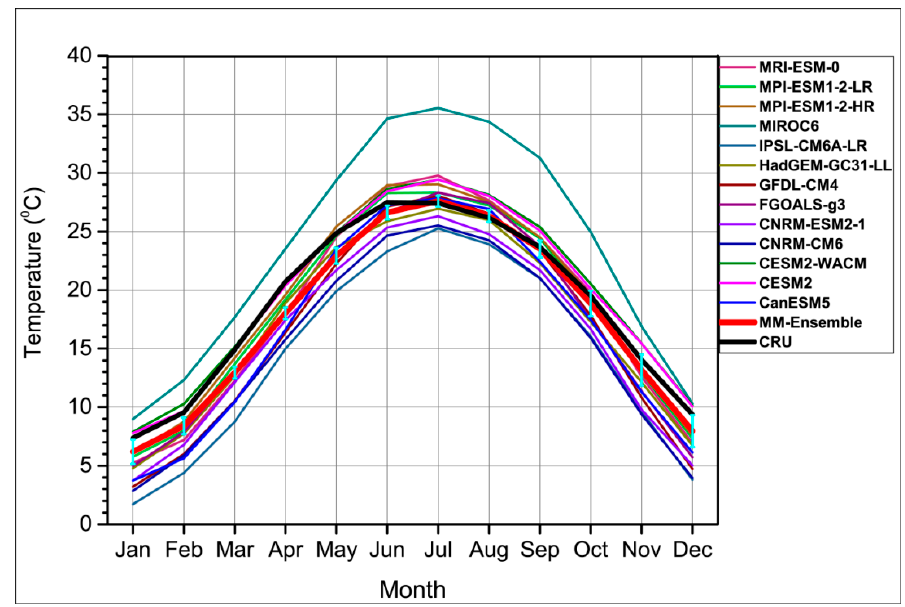
Figure 2. The annual cycle of mean temperature over Pakistan for 1970–214 based on observed climatic research unit (CRU), CMIP6 individual models, and the ensemble mean (MM-Ensemble) depicting overestimation and underestimation of temperature. The CRU is displayed in the black color line and MM-Ensemble in the red color line. The turquoise color bars on MM-Ensemble represent the deviation of values from the mean in each month.